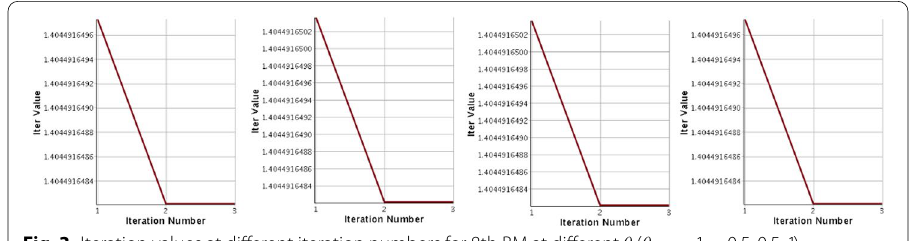
Fig. 3 Iteration values at different iteration numbers for 8th BM at different θ ( θ = − 1, − 0.5,0.5,1 ) respectively for g 3 ( x ) .